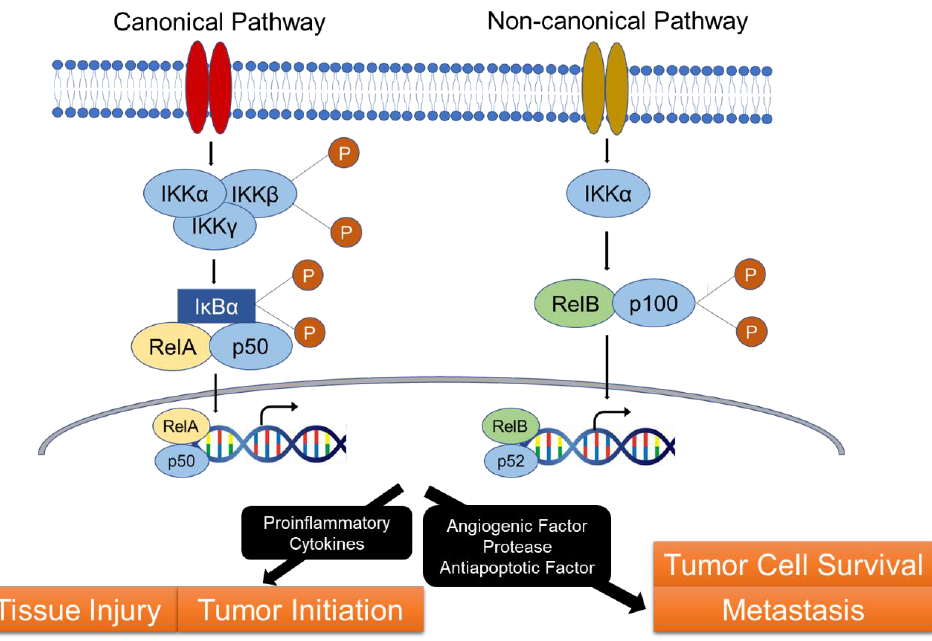
Figure 2. NF- κ B pathway and inflammatory-associated carcinogenesis. NF- κ B is involved in IBD pathogenesis. NF- κ B signaling includes two pathways (the canonical and non-canonical pathways), and NF- κ B forms a complex with the inhibitor I κ B in the cytoplasm in both pathways. Activation of the canonical pathway results in phosphorylation of I κ B α by the I κ B kinase (IKK) complex. This leads translocation of RelA / p50 into the nucleus, and activation of the transcription of target genes. Activation of the non-canonical pathway leads the degradation of the p100 to p52. The p52-RelB complex translocates into the nucleus and leads the transcription of target genes. This pathway is involved in the pathogenesis of IBD. It is also involved in the carcinogenesis with cytokine-induced tissue injury, tumor initiation, and tumor progression.